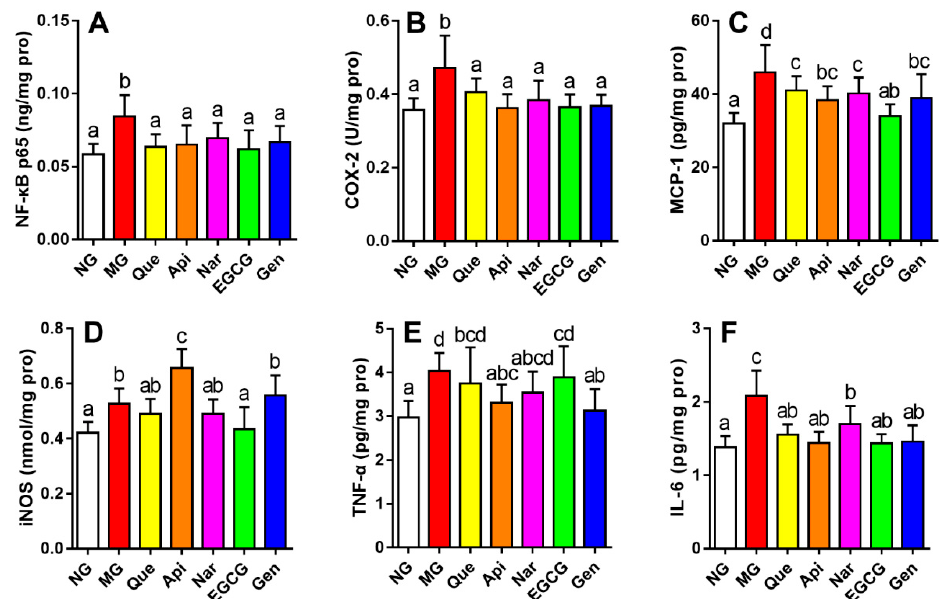
Figure 5. Effect of five kinds of flavonoids on hepatic inflammatory stress: ( A ) nuclear factor kappa B p65 level; ( B ) cyclooxygenase 2 level; ( C ) monocyte chemoattractant protein 1 level; ( D ) inducible nitric oxide synthase level; ( E ) tumor necrosis factor α level; ( F ) interleukin-6 level. Values are expressed as the mean ± SD ( n = 10). Labeled means without a common letter differ ( p < 0.05). NG, normal group; MG, model group; Que, quercetin; Api, apigenin; Nar, naringenin; EGCG, epigallocatechin gallate; Gen, genistein.